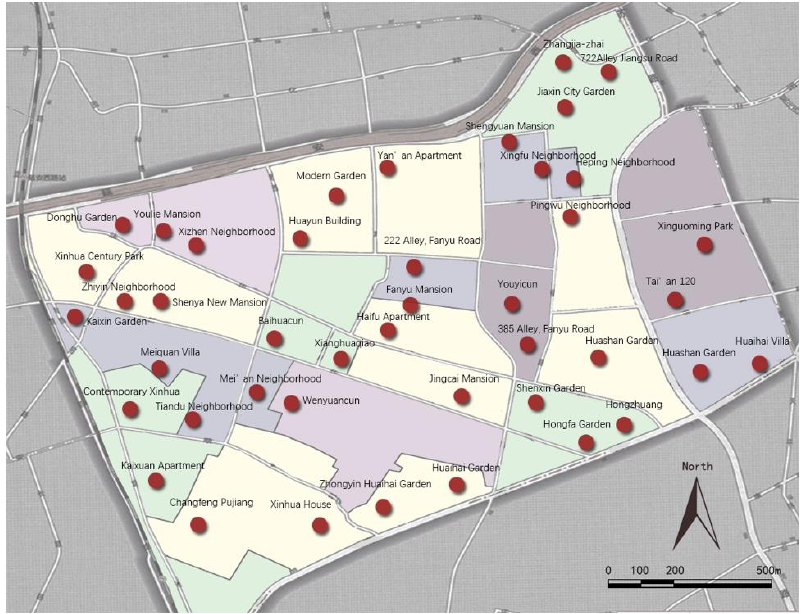
Figure 3. Map of the residential districts sample.